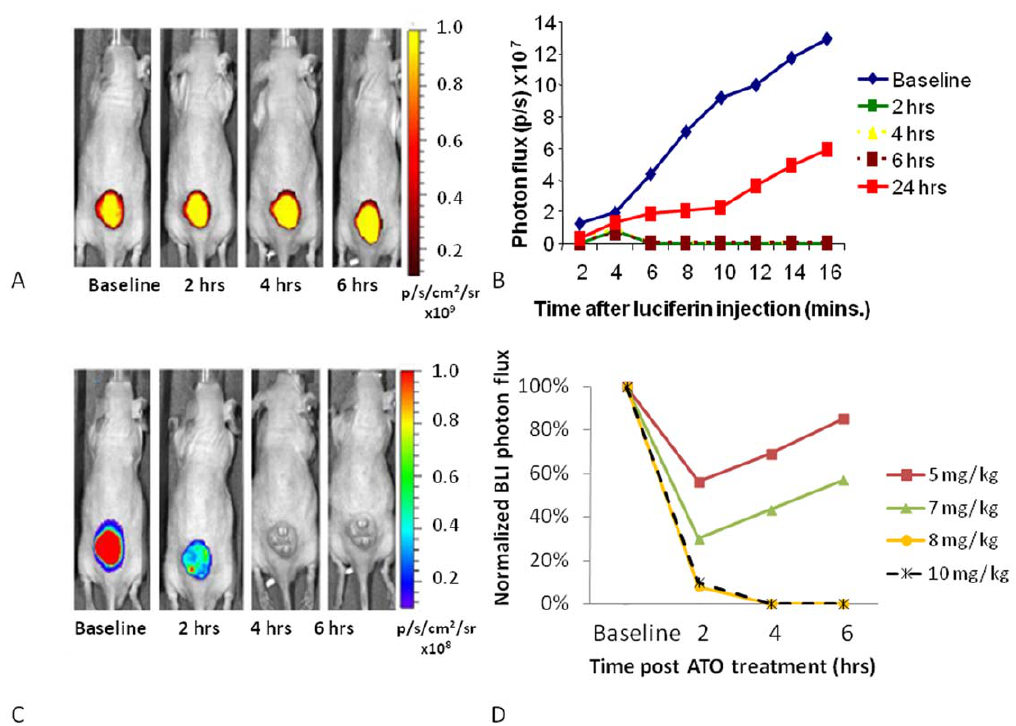
Figure 2. Optical assessment of vascular disruption in U87-mCherry-luc tumors. Optical imaging was performed at various times before and after administration of ATO. On each occasion FLI was performed first and then D -luciferin was administered SC in the neck and BLI was performed over a period of 16 mins. A ) Sequential FLI with respect to a dose of 8 mg/kg ATO administered IP, B ) Corresponding time course of bioluminescent signal evolution in this mouse following luciferin injection at respective times, C ) BLI signal intensity at the 10 minute time point following luciferin administration, D ) Normalized BLI signal intensity at 10 minute time point after administration of luciferin indicating vascular shutdown following various doses of